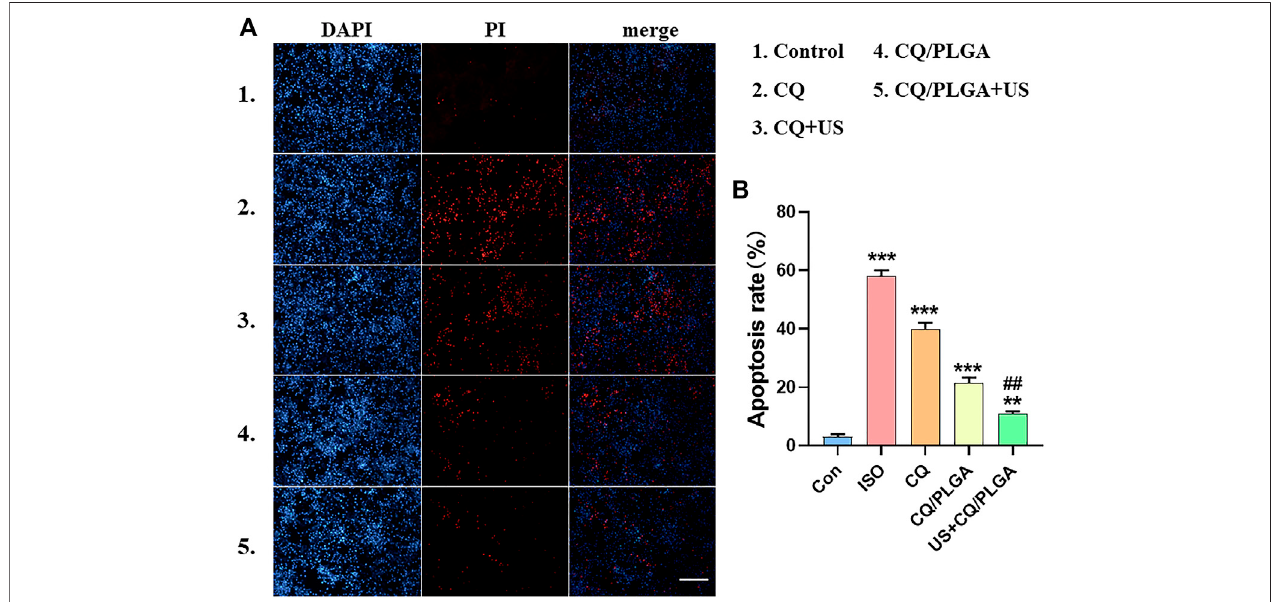
FIGURE8 | Evaluation ofthe inhibitory effect ofultrasound combined with CQ/PLGA on ferroptosis in HL-1 using fl uorescent apoptosis detection. (A,B) When the fusion degree of HL-1 cells reached 80%, HL-1 cells were treated with different treatments (the control group did not do any treatment). After incubation for 24 h, the nuclei werecounterstained withPI.Theresults ofImageJanalysisshowed thatultrasound combined withCQ/PLGAcouldinhibittheapoptosisofHL-1inducedbyISO. TheapoptosisrateoftheISOgroupwas58.08%±1.58%,andtheapoptosisrateoftheUS+CQ/PLGAgroupwas10.90%±0.68%(vs.controlgroup,** p < 0.01, *** p < 0.001, vs. other groups, ## p < 0.01, n = 5, Bar = 50